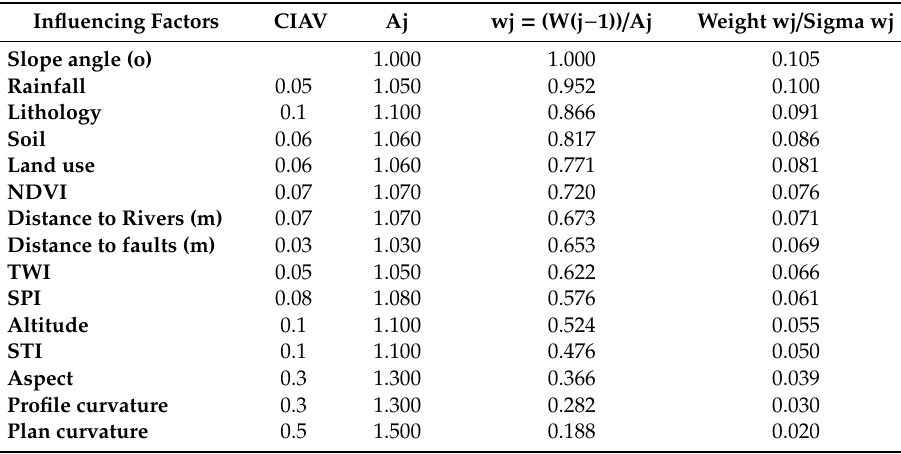
Table 3. Calculate weight of influencing factors by the SWARA algorithm.